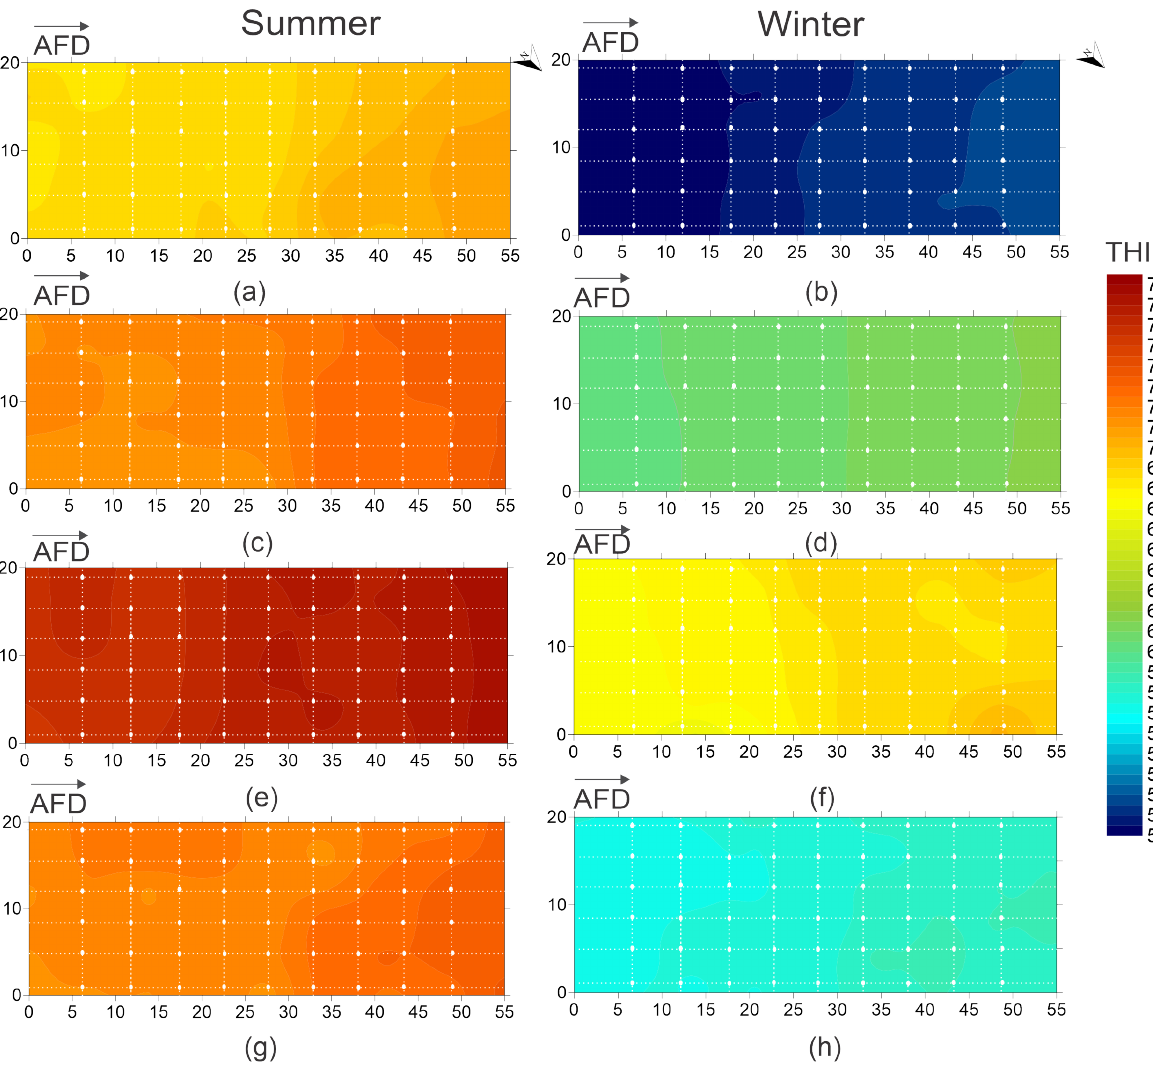
Figure 7. Spatial distribution of the Temperature and Humidity Index (THI) during the dawn (00:00a.m. to 05:00a.m.), morning (06:00a.m. to 11:00a.m.), afternoon (12:00a.m. to 05:00 p.m.) and night (06:00p.m. to 11:00p.m.) inside the compost bedded pack barn (CBP) during the summer and winter experimental